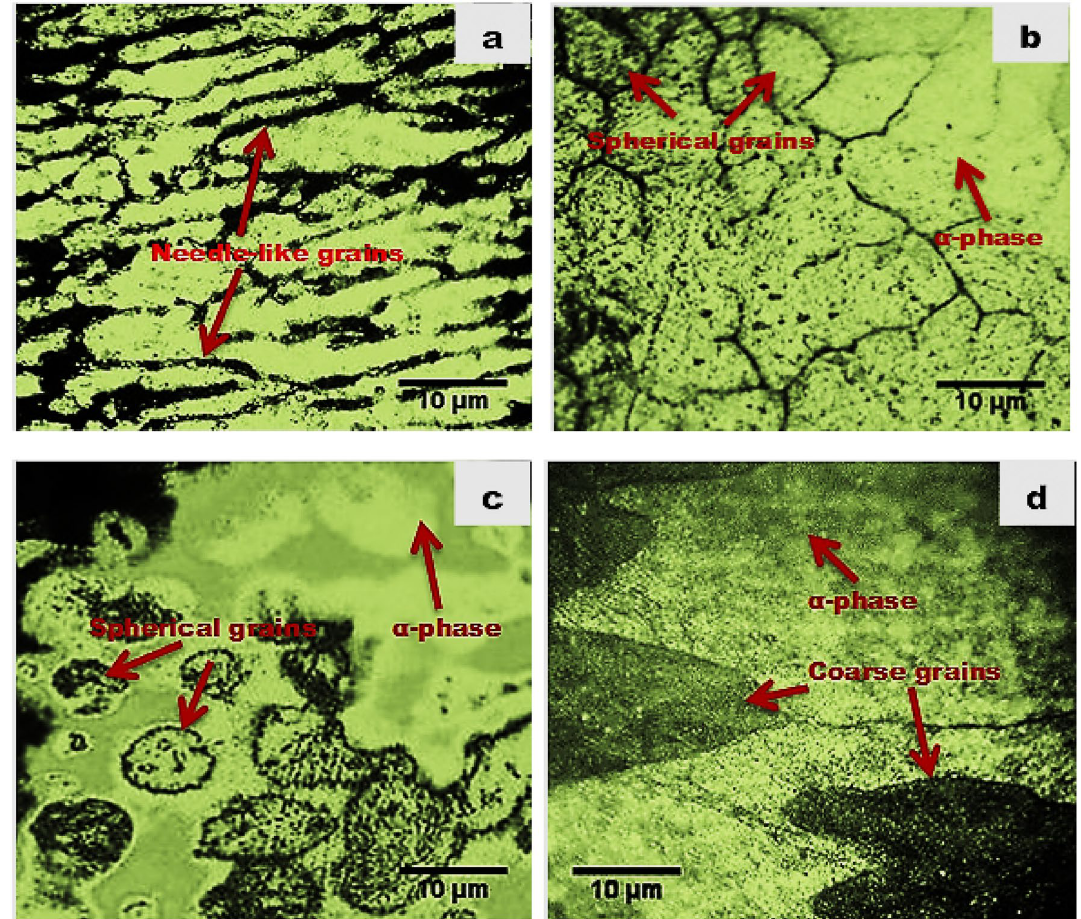
Fig. 4 Optical migrographs of silicon bronzes a Cu–3Si, b Cu–3Si–0.1Zn, c Cu–3Si–0.5Zn, and d Cu–3Si–1Zn (Mag: